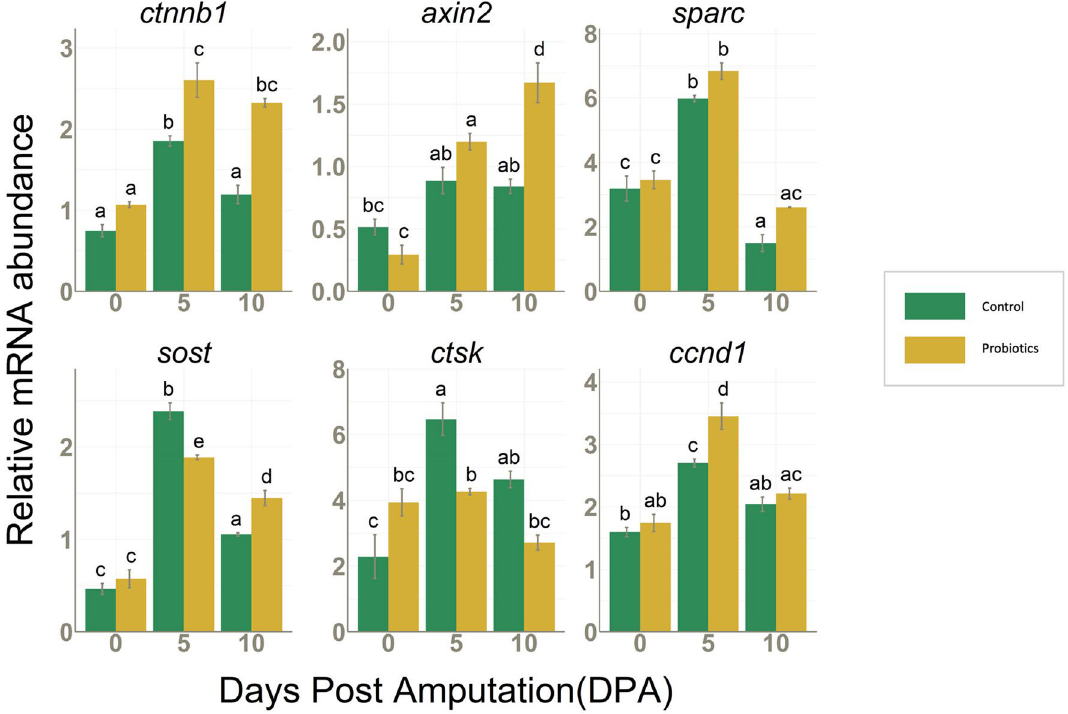
Figure 5. ctnnb1, axin2, sparc, sost, ctsk and ccnd1 mRNA values normalized against rplp0 and rpl13 in fins collected from C (n = 3) and P (n = 3) groups at 0, 5 and 10 DPA. Data are presented as mean ± S.D. Different letters over histograms indicate statistically significant difference among groups. Two-way ANOVA and Tukey’s multiple comparison test are used, and statistical significance was set at p <